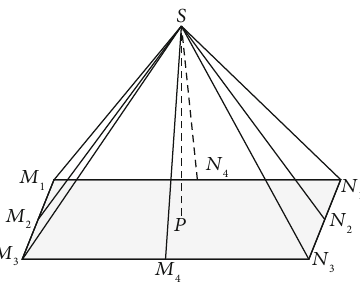
Figure 11: Rectangular cone